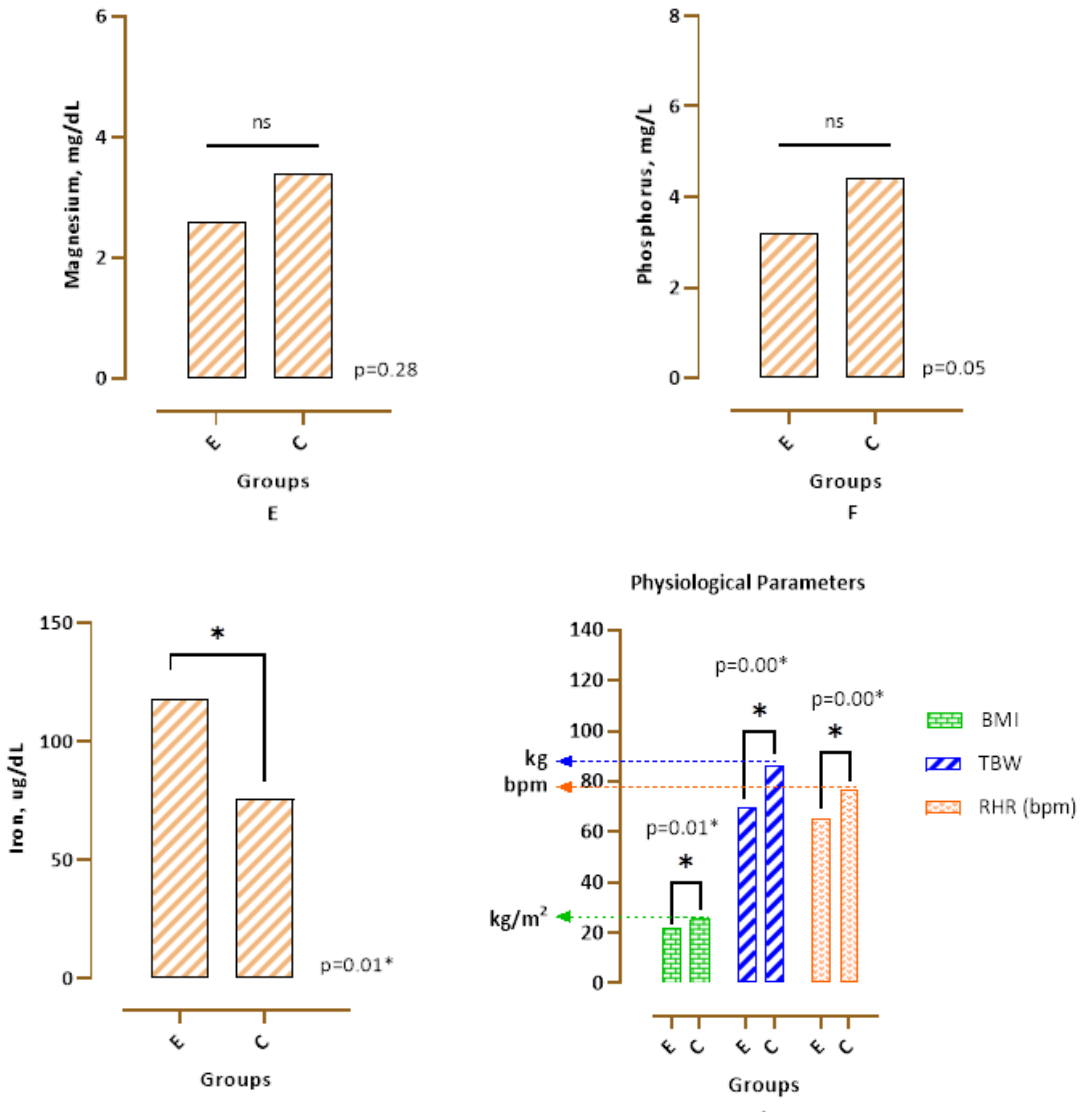
Figure 2. The figure below demonstrates the post-test serum elements magnesium, phosphorus, iron, BMI, TBW and RHT (Experimental, Control;